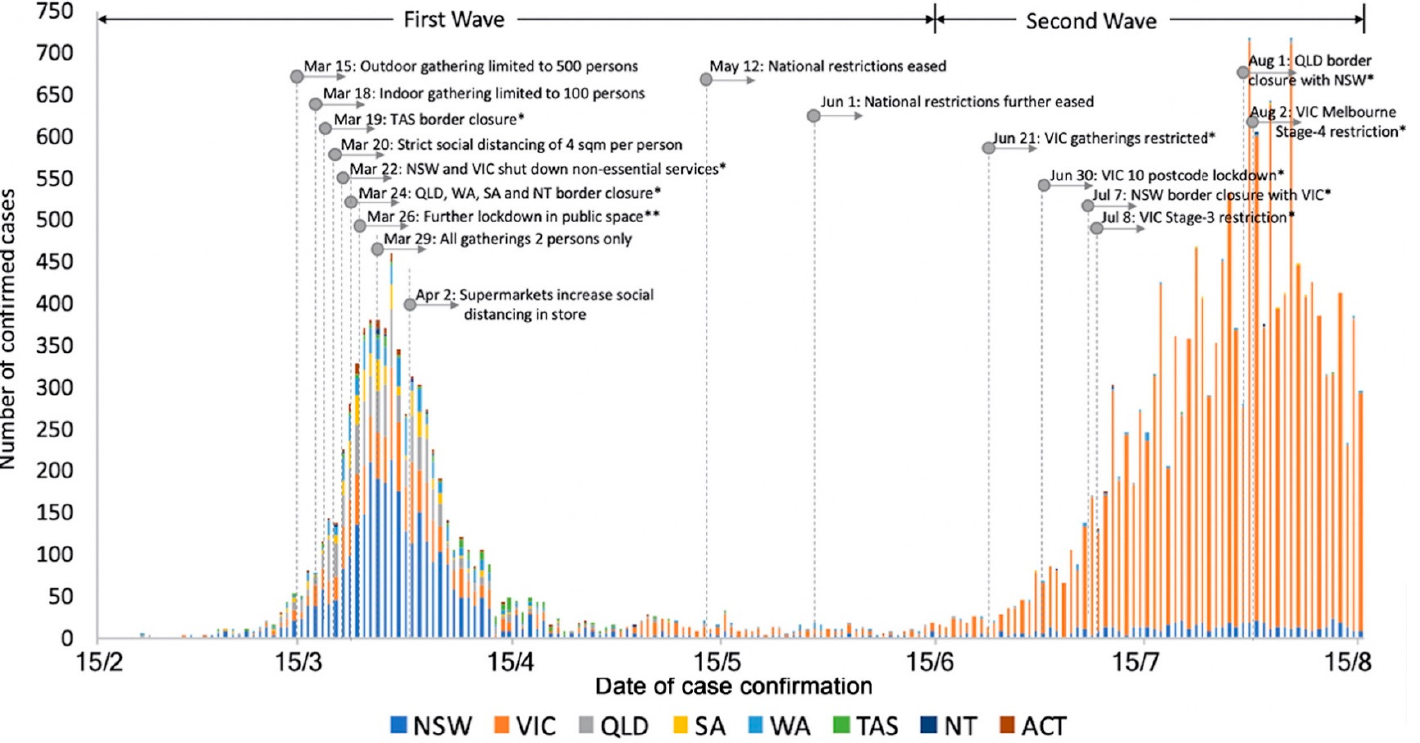
Figure 1. Confirmed COVID-19 cases in each state / territory and a timeline of policy intervention. Note: NSW: New South Wales; VIC: Victoria; QLD: Queensland; SA: South Australia; WA: West Australia; TAS: Tasmania; NT: North Territory; ACT: Australian Capital Territory; *: Policies at the state level; **: Further lockdown includes the closure of restaurants, cafes, food courts, auction houses, open house inspections; weddings restricted to 5 people; funerals to 10 people.